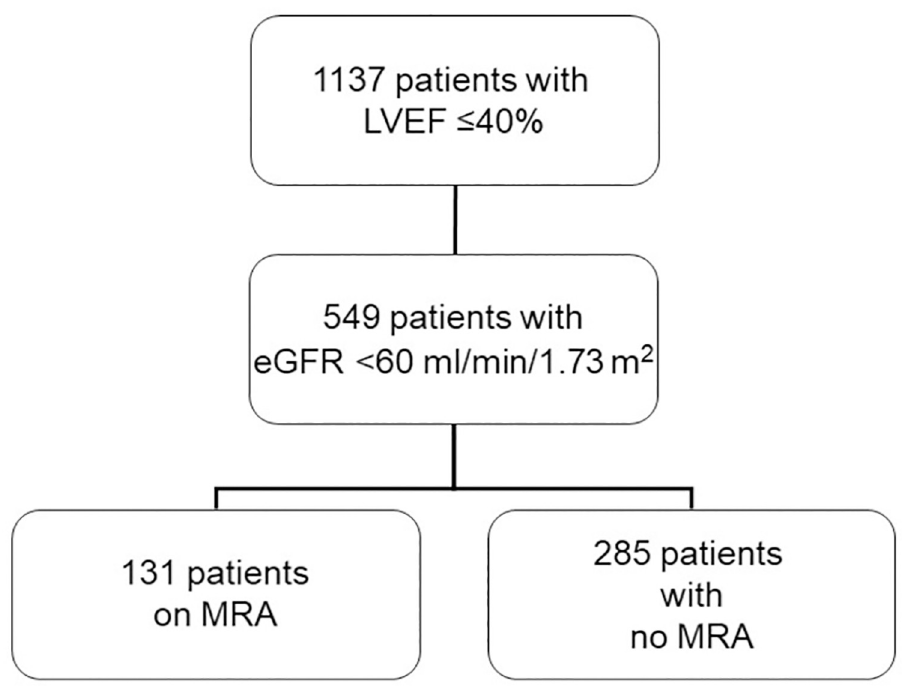
Fig 1. Patient selection flow